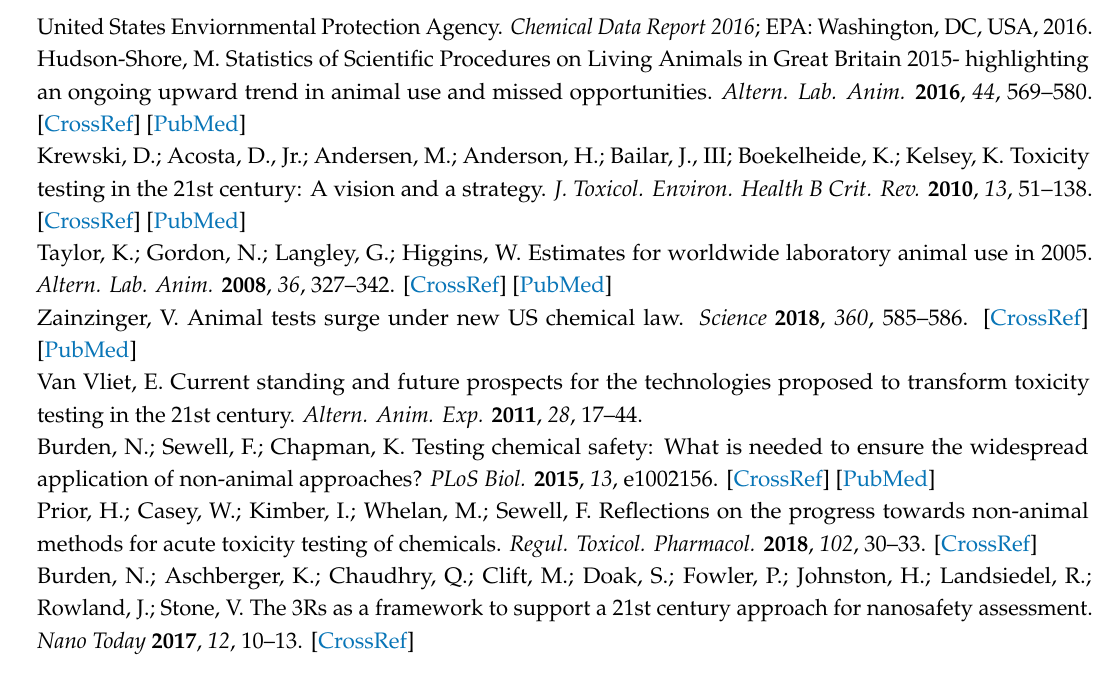
Figure S2, Single-cell phenotypes from live cell imaging; Figure S3, Cell viability assay after silver treatment. The videos include: Video S1, Representative video showing untreated RPE-1 cells (corresponding to Figure 2a, untreated); Video S2: Representative video showing RPE-1 cells engulfing AgNPs present in the extracellular space (corresponding to Figure 2b); Video S3: Representative video showing a binucleate cell undergoing tripolar cell division (corresponding to Figure